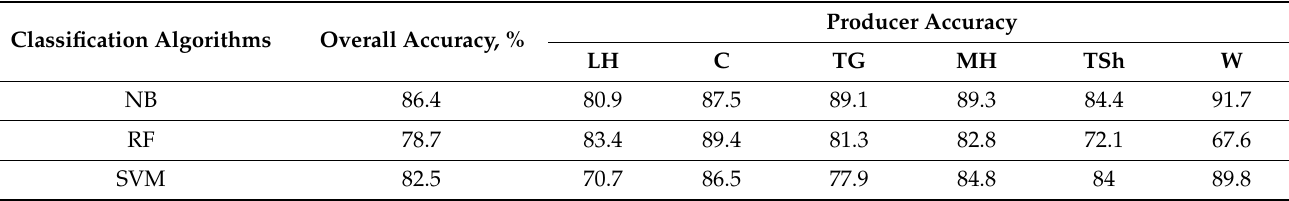
Table 3. Algorithms’ classification